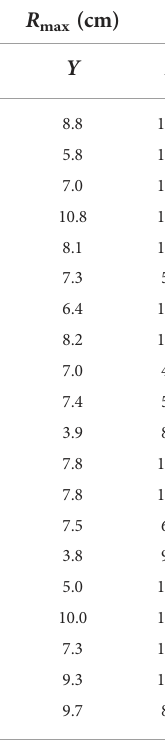
TABLE 1 Patient